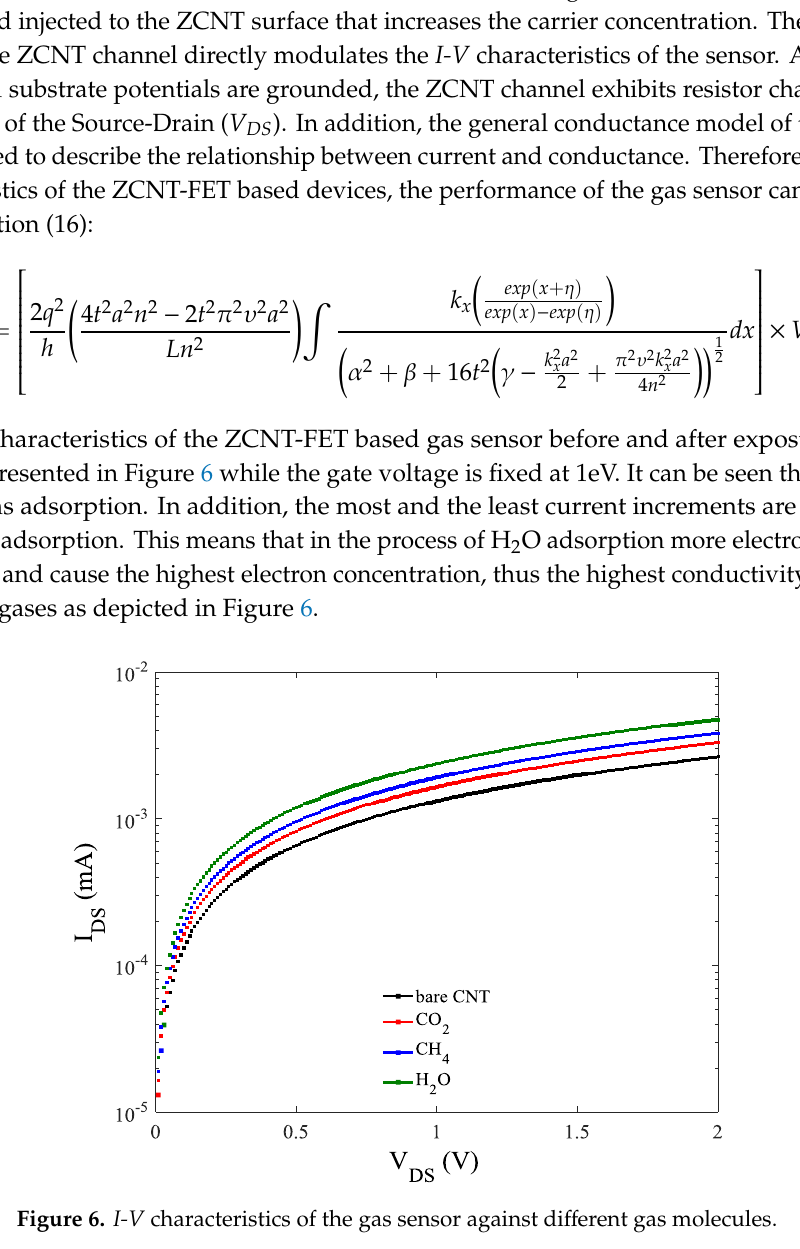
Figure 7. The response of ZCNT-FET based gas sensor toward adsorbed gas molecules. 3. Conclusions Gas sensors are being extensively used in diverse industries to monitor and control the leakage and concentration of gases and for safety purposes. Recently, a new generation of gas sensors based on carbon allotropes, especially carbon nanotubes, presenting excellent sensing performance has emerged. Therefore, in this paper, we propose a set of new analytical models to investigate the performance of the zigzag CNTFET-based gas sensor and analyze the variation of its physical and electrical properties against various target gas molecules. We used the tight-binding technique to build energy dispersion relation of ZCNT and to interpret the behavior of its electronic band structure after gas adsorption. Through this, conductance and I-V characteristics of the ZCNT sensor were formulated and applied for gas detection. On the other hand, a sensor response analysis was performed to measure semiconducting ZCNT against CO 2 , H 2 O, and CH 4 gases. To validate our